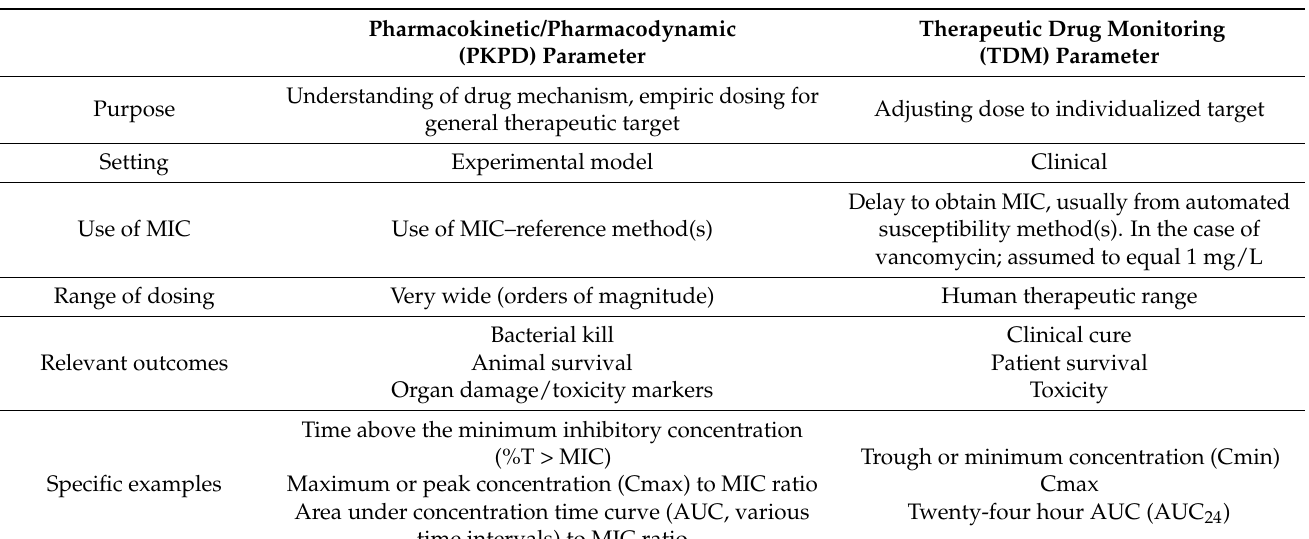
Table 1. Characteristics of pharmacokinetic/pharmacodynamic parameters versus therapeutic drug monitoring